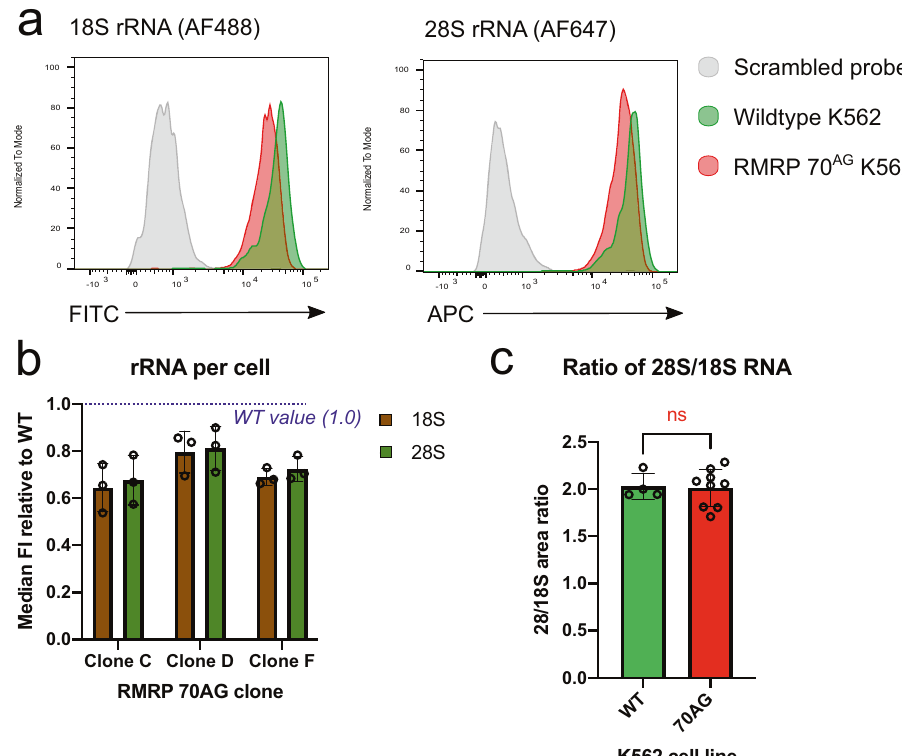
Fig. 3 70 AG mutation in RMRP causes a reduction in rRNA per cell. a Example data from FlowFISH experiments, showing 18 S and 28 S rRNA detected by fl uorescently-labeled antisense oligonucleotide probes, or signal from control probes with scrambled sequences. Gated on morphologically live cells. b Quanti fi cation of rRNA signals obtained in FlowFISH experiments. In each experiment, intensity values for each 70 AG clone were normalized to the signal from wild-type cells. The gating strategy is shown in Supplementary Fig. 2c. The plot shows mean of data from three independent experiments, with SD. c Ratio of 28 S to 18 S rRNA in WT and 70 AG cells, as determined by BioAnalyzer analysis. Mean and SD of data obtained in three independent experiments (total of 4 WT and 9 mutant samples). Nonsigni fi cance concluded from two-tailed unpaired t -test ( p = 0.8963, t = 0.1334, df = 11). Source data are provided as a Source Data fi